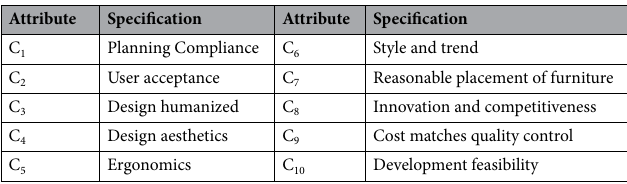
Table 5. Attributes defined in the case study.